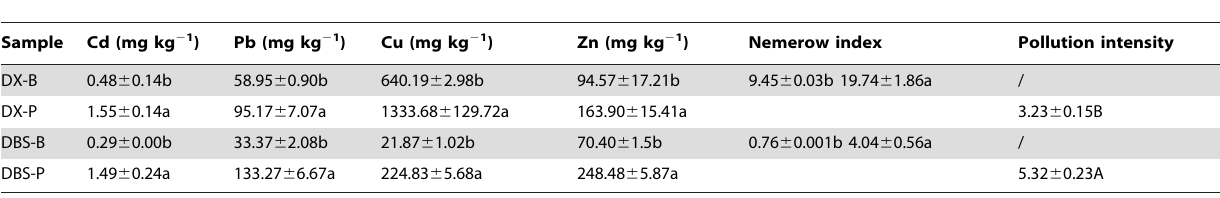
Different lowercase characters indicate significant different ( p , 0.05) between polluted soils (PS) and background soils (BGS) in a single site. Different capital letters for pollution intensity indicate significant different ( p , 0.05) between the two